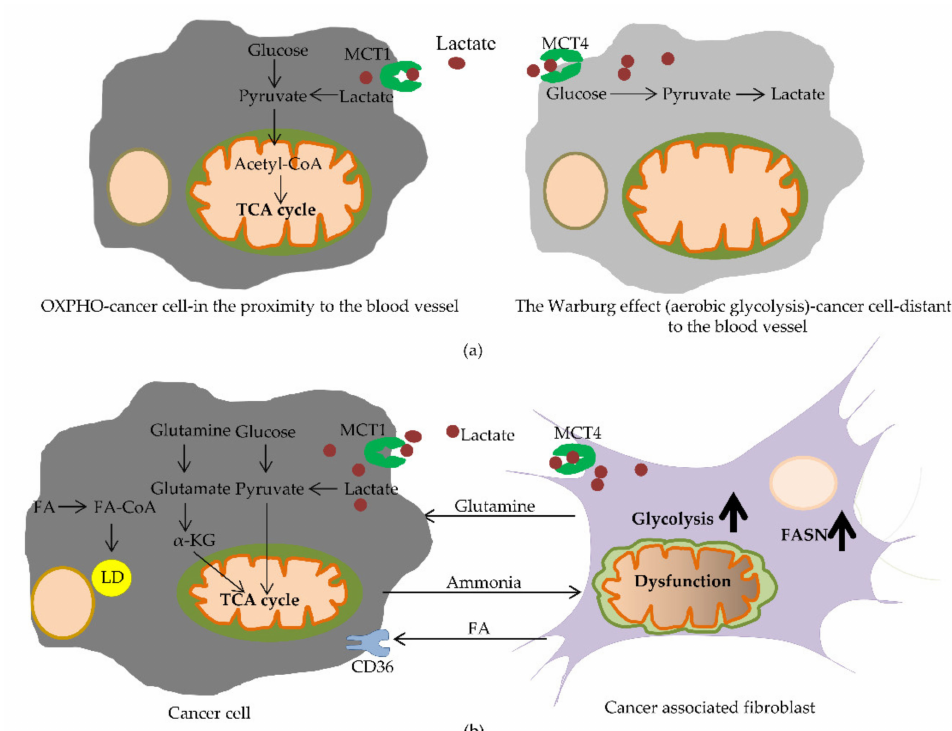
Figure 5. The Warburg effect (aerobic glycolysis) and oxidative phosphorylation (OXPHO) in cancer cells. ( a ) Due to the different localization of cancer cells and consequently different oxygen gradient and supply, glucose can be either converted to lactate or to CO2 through TCA and electron chain transport (TCA cycle, ETC), producing energy in the form of ATP as 2 ATPs and 32–36 ATPs, respectively. ( b ) Metabolic crosstalk between cancer cells and cancer-associated fibroblast (CAFs). Lactate produced in CAFs is transported to the cancer cells via MCT-4 and MCT-1 transporters. In cancer cells, lactate is converted into pyruvate, which is coupled further to the TCA cycle. In addition, increased expression of FASN in CAFs leads to an enhanced level of fatty acids transported into cancer cells through CD36 and used for lipid synthesis, causing increased lipid droplet (LD) formation. Glutamine produced in CAFs affects TCA cycle in cancer cells, while ammonia from cancer cells influences the function of